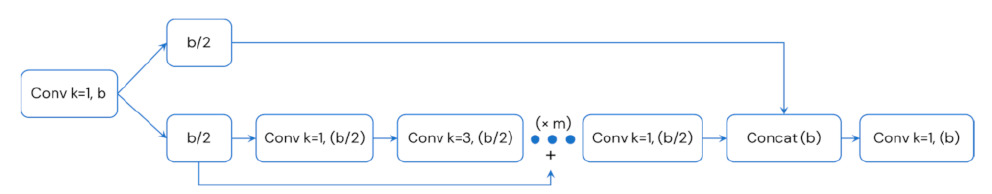
Figure 4. Cross-Stage Partial Connection Block in